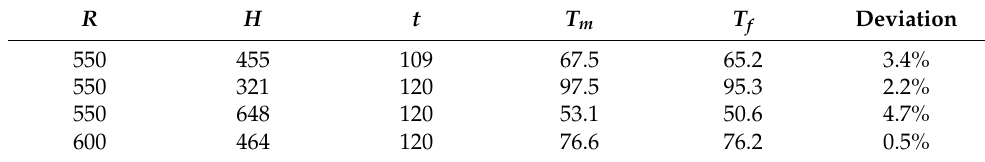
Table 3. Parameter list and comparison.